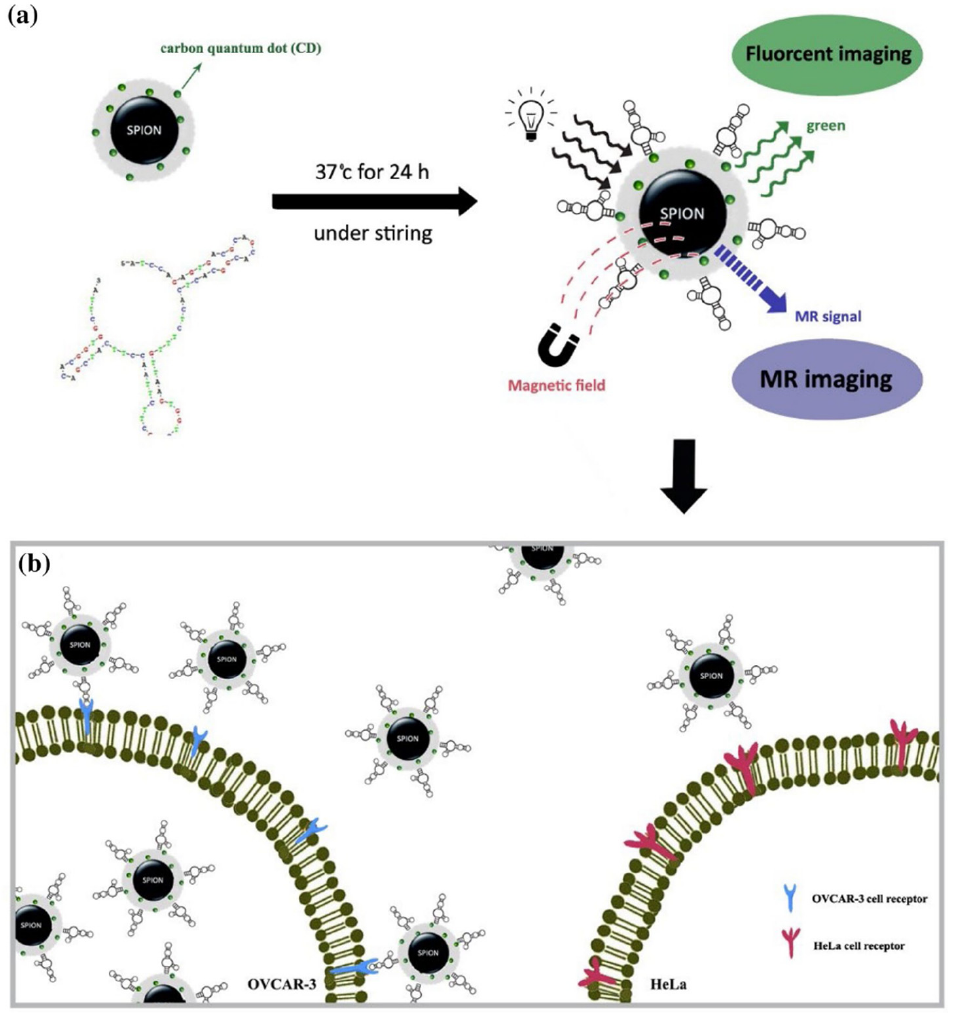
Figure 3. The illustration of the aptamer-targeted nanoprobe for multimodal fluorescence/magnetic resonance imaging ( a ) and different internalization of aptamer-superparamagnetic iron oxide nanoparticle-carbon dots into target and control cells ( b ) [65]. Copyright 2021, Springer.